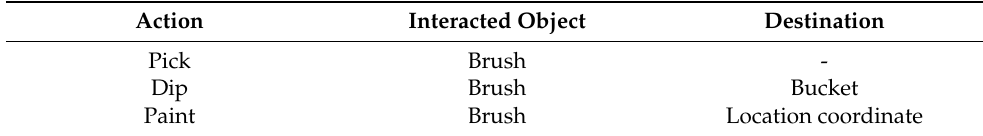
Table 1. Action base illustrating a painting